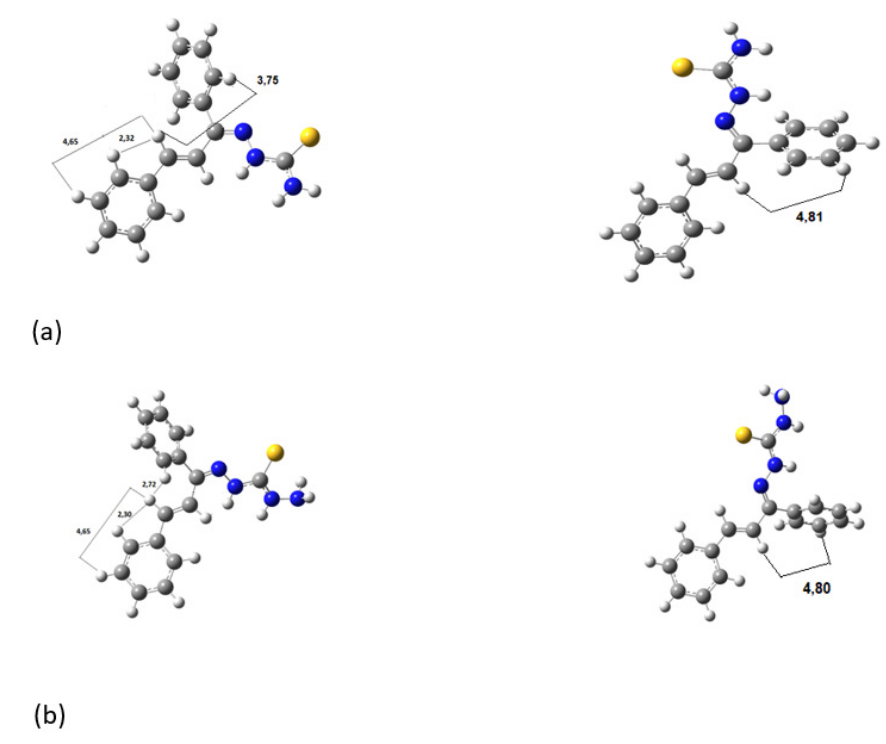
Figure 7. Most probably conformations for ( a ) KKI15 and ( b ) KKI18 . Table 3. The most important comparative distances in the complex obtained through 2D NOESY and DFT MD calculations for KKI15 (top) and KKI18 (bottom).